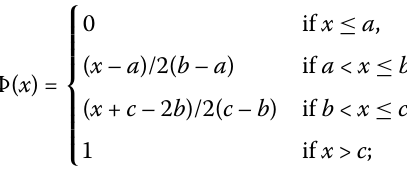
Figure 4 The credibility distribution of ξ ∼ N ( a